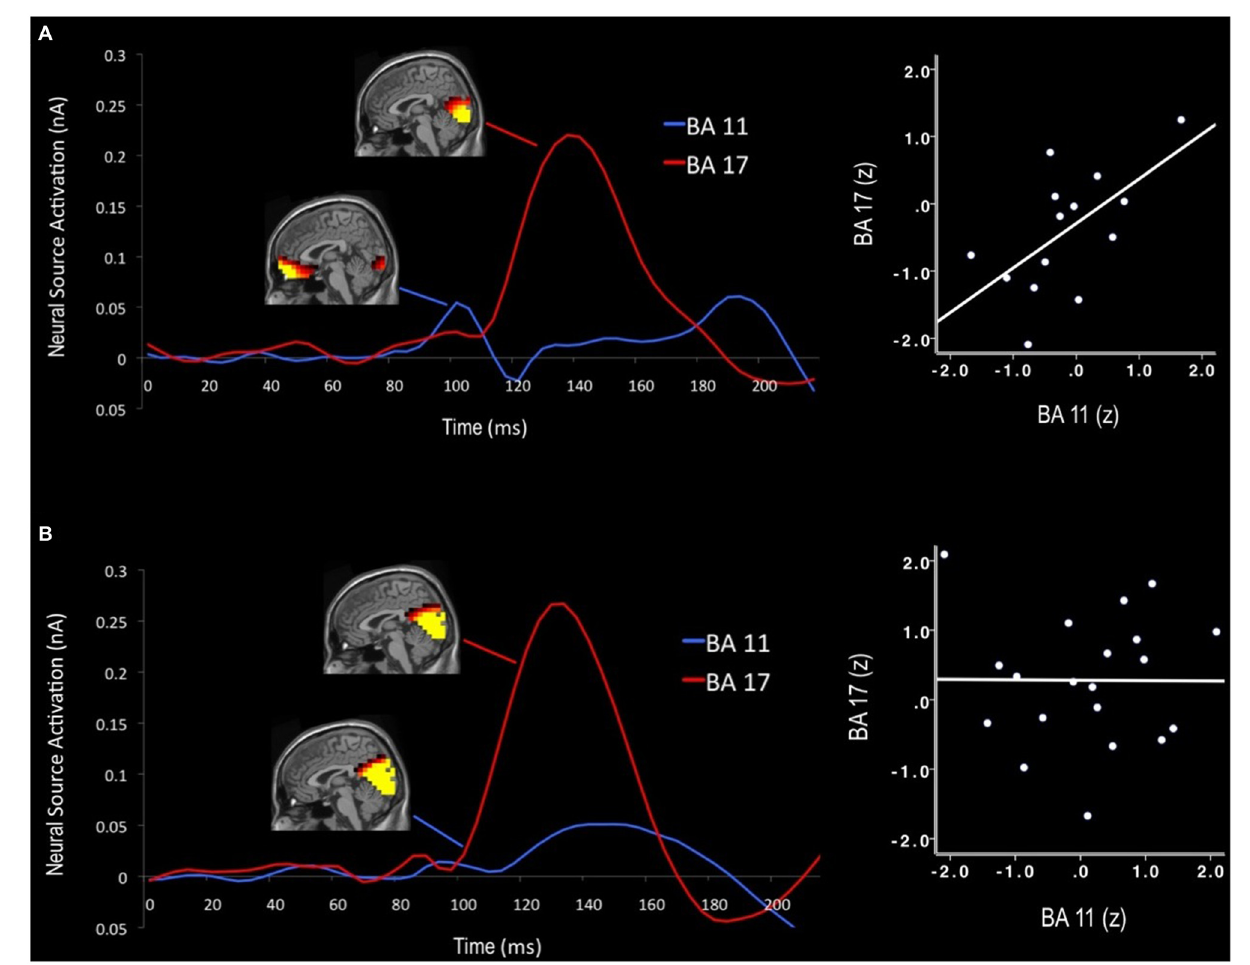
FIGURE 4 | Neural time course of distracter color-gray difference waves for older (A) and younger adults (B). Activation maps display cortical activity at 100 ms and 140 ms that was preferential for color-related distracter processing. Early orbitofrontal cortex (OFC; BA 11) activations predicted subsequent visual cortex activity (BA 17) in older adults, but not for younger adults. Note: Scales visible source activations differ for each time window (100 ms: visible range = 0.06–0.10 nA; 140 ms: visible range = 0.15–0.25